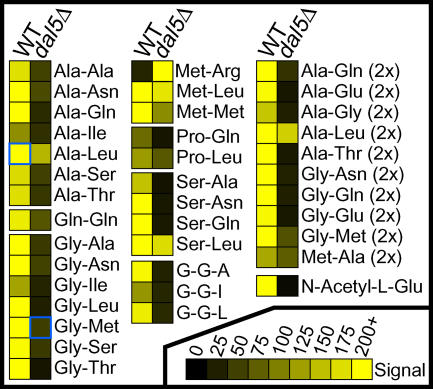
Deletion of DAL5 in Strain RM8 Strongly Affects the Utilization of a Subset of Assayed DipeptidesAll instances in which RM8 and RM8-dal5Δ signal values differ by more than 50 units and conform to our reliability criteria (see Figure 2) are presented. Dipeptides followed by “(2×)” are present in the PM assay plates at twice the concentration of the other dipeptides.